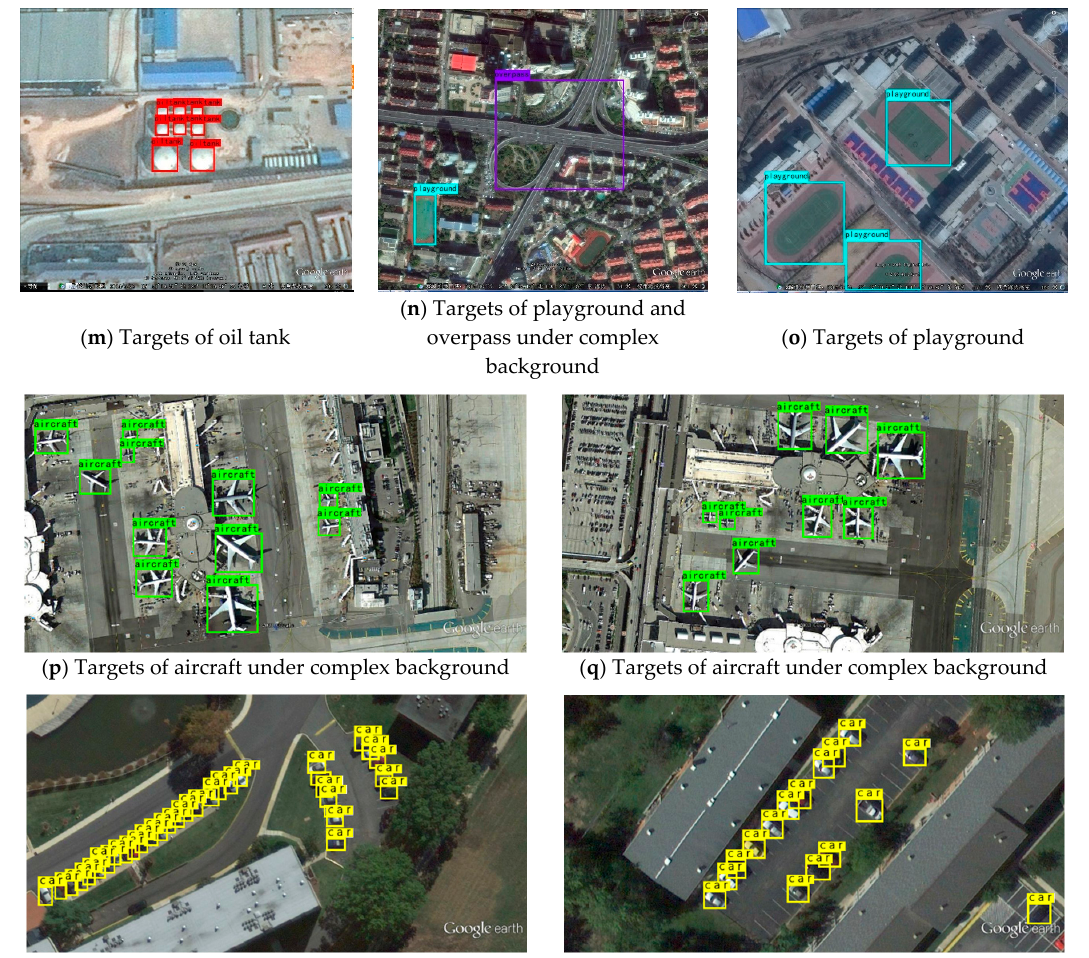
Figure 10. The detection results of the improved YOLO-V3.